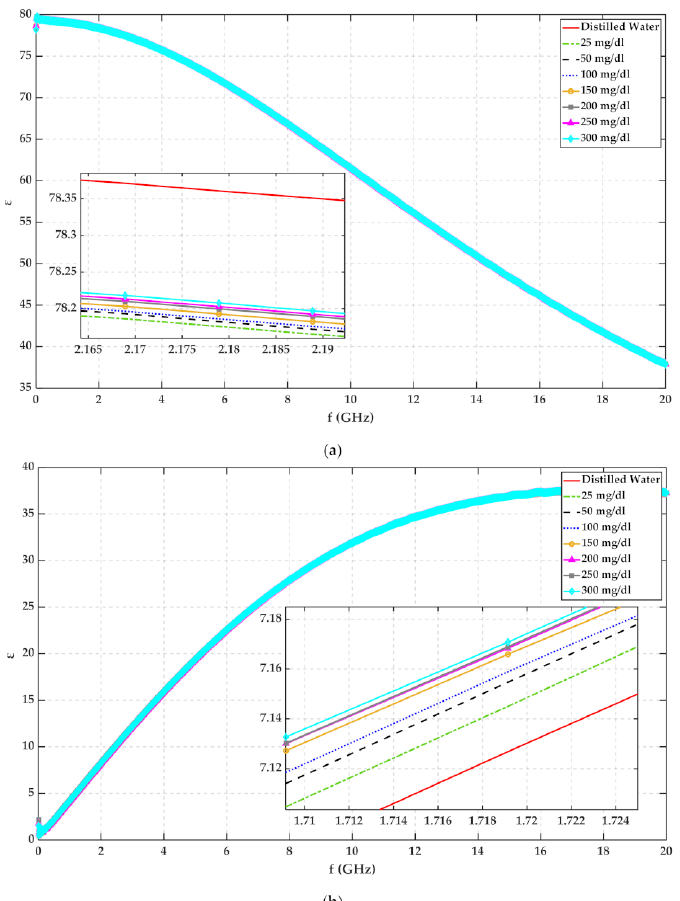
Figure 1. The measured permittivity of 23 ◦ C distilled water with different glucose concentration ( a ) real part ( b ) imaginary